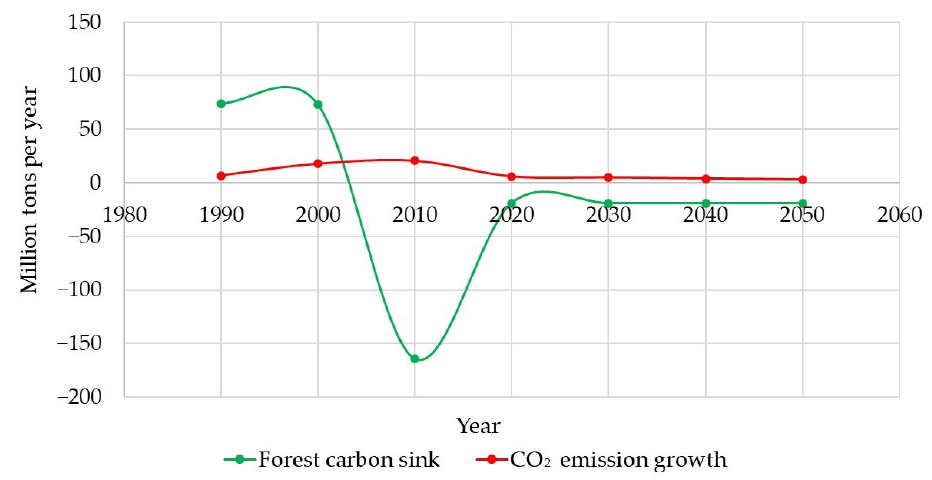
Figure 9. Change and prediction in CO 2 emission reduction through forest carbon sink in Malaysia.